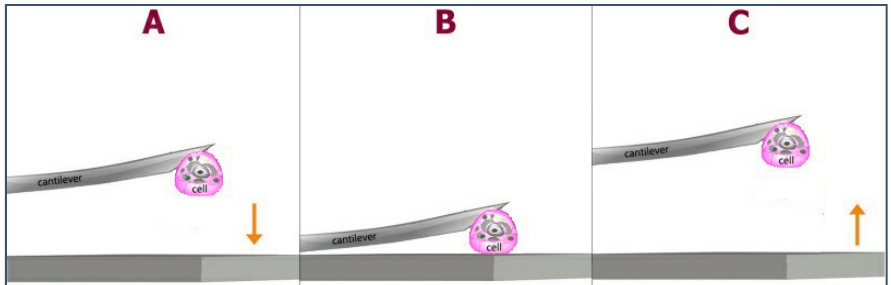
Figure 4. Global strategy for the cell adhesion measurements. ( A ) Approach. Chondrocyte is attached to the cantilever and approaches the chitosan substrate at constant velocity. ( B ) Contact. Chondrocyte is in contact with the substrate during the contact time (t c ) under an applied contact force (F c ). ( C ) Retraction. The cantilever is retracted, and the cell interaction response is obtained. Figure 5. During retraction, complete detachment of the cell occurs and vertical force F(nN) of the cantilever is represented versus piezo height (z). During the contact between the chondrocyte and the surface, both indentation and adhesion interactions